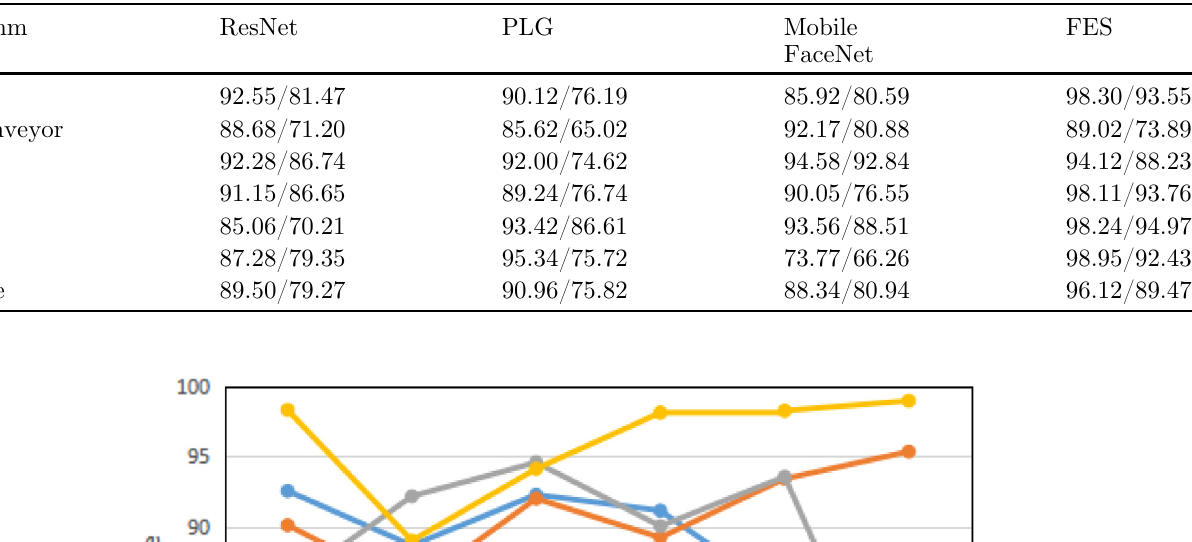
Table 6. The recognition effect is signi fi cantly different using the same convolutional neural network and different feature extraction methods. All values are in %.